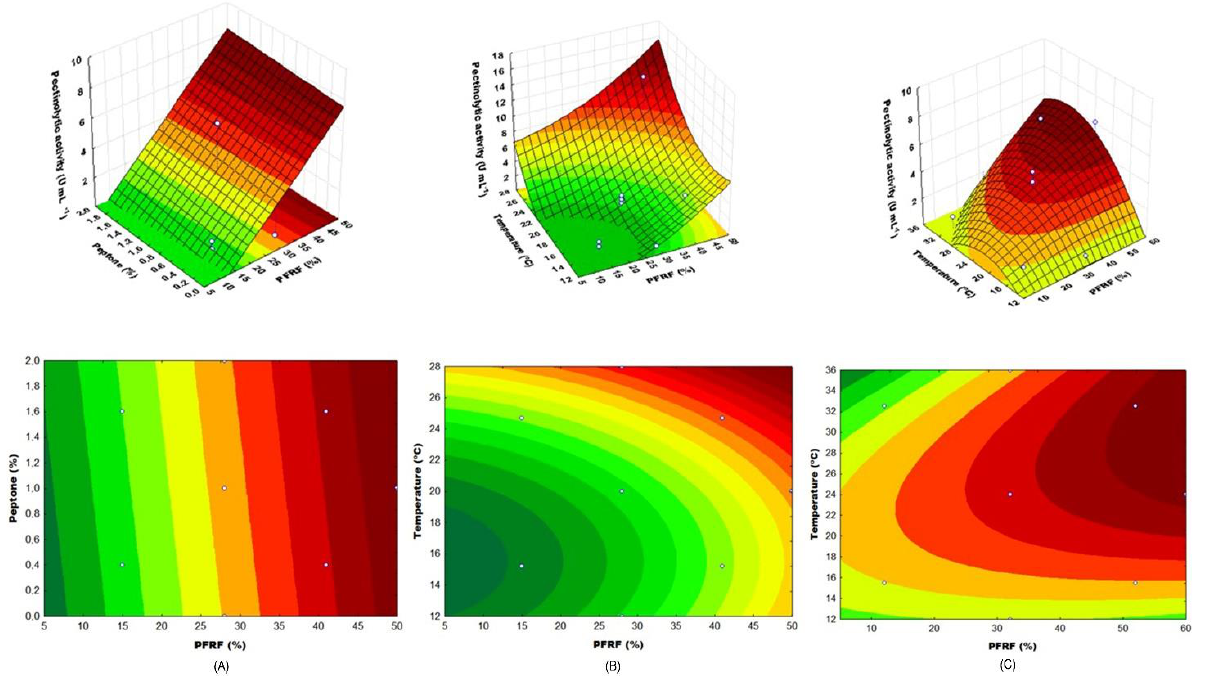
Figure 2. Response surfaces and contour curves for the influence of the tested variables in the secretion of total pectinolytic activity (U mL − 1 ) by S. cerevisiae . ( A ) peptone content and PFRF content (g 100 g − 1 )—CCRD-1; ( B ) temperature ( ◦ C) and PFRF content (g 100 g − 1 )—CCRD-1; ( C ) temperature ( ◦ C) and PFRF content (g 100 g − 1 ) — CCRD-2.